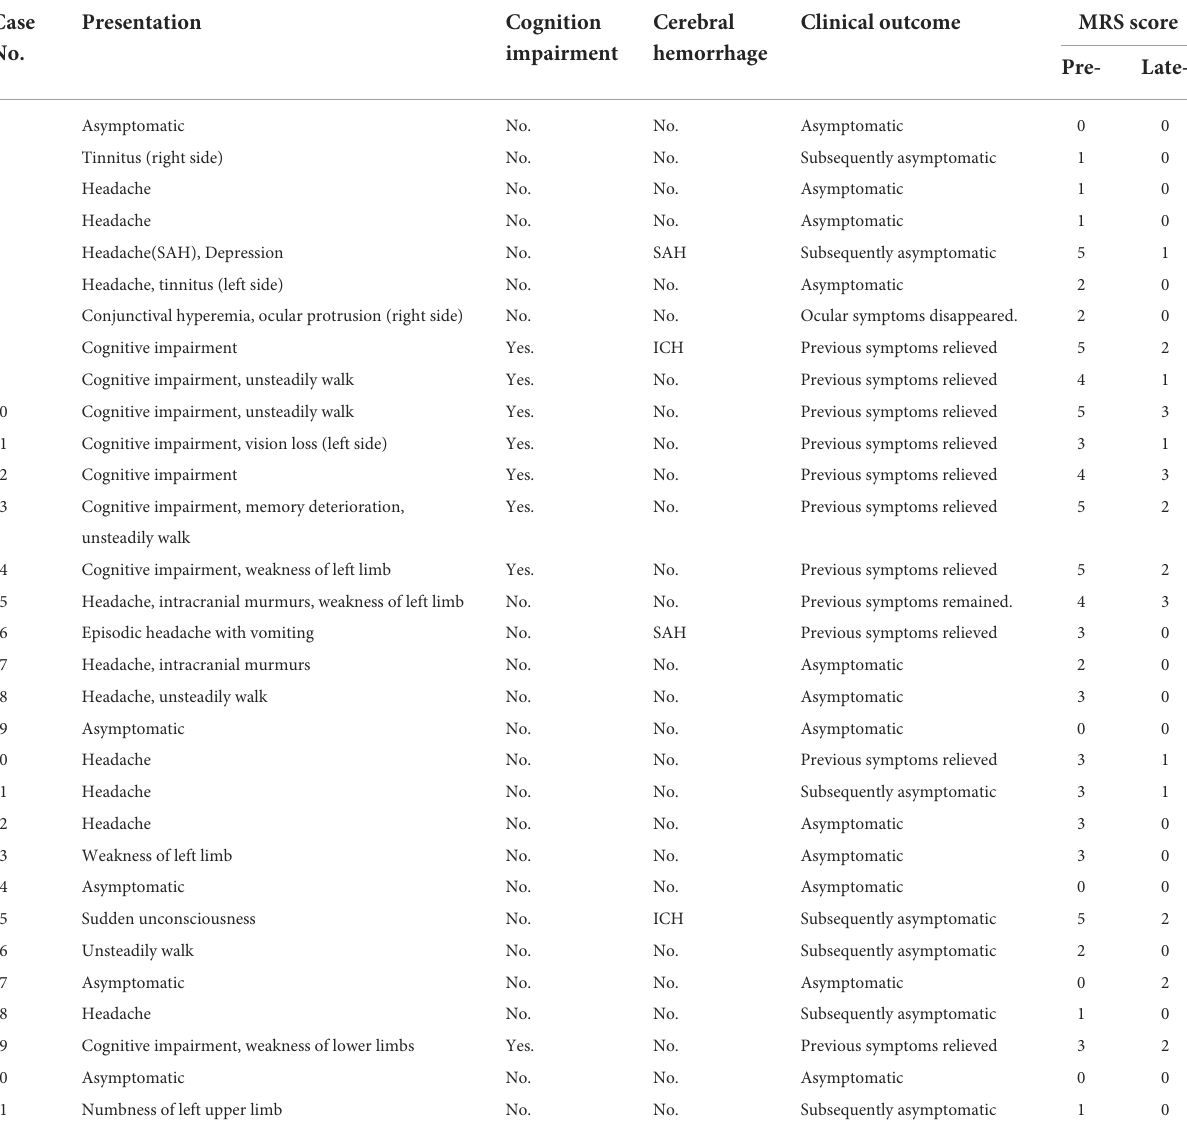
TABLE 1 Clinical presentations, angiographic and clinical outcomes and MRS